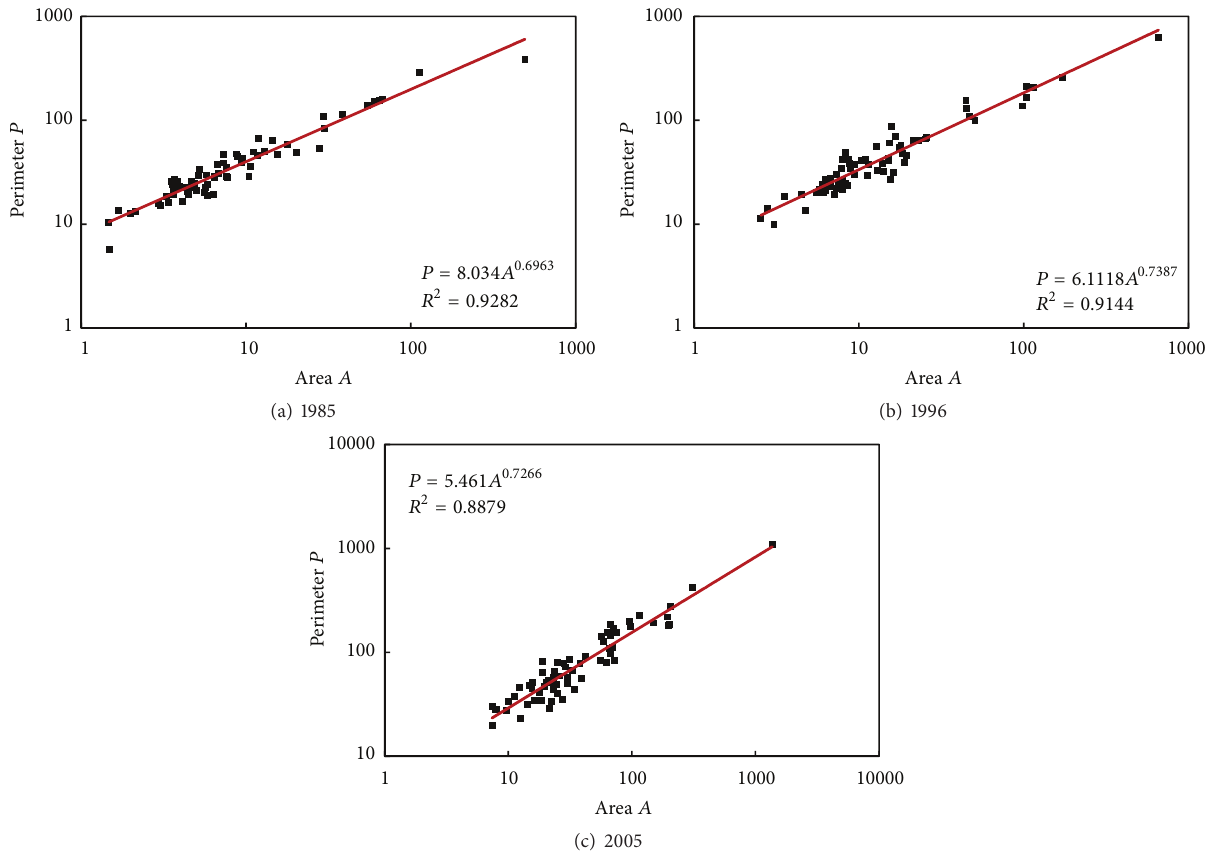
Figure2:TheallometricscalingrelationsbetweenurbanareaandperimeterofthecitiesandtownsinYangtzeRiverDelta,China(1985–2005).